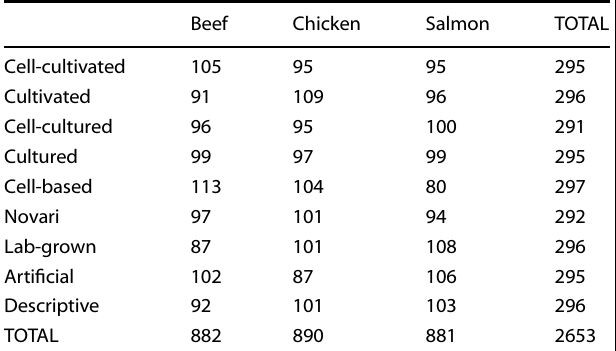
Table 3. Number of participants in each of 27 product/label conditions.